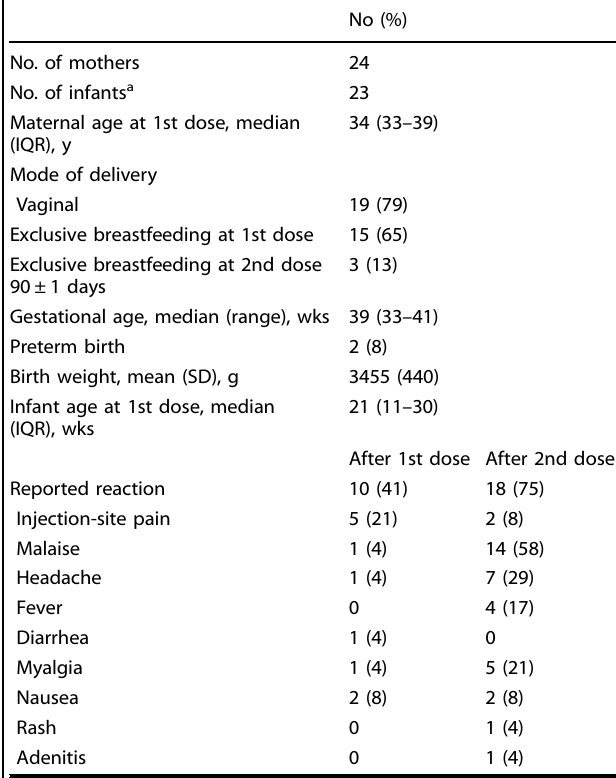
Table 1. Demographic and clinical characteristics of women and infants